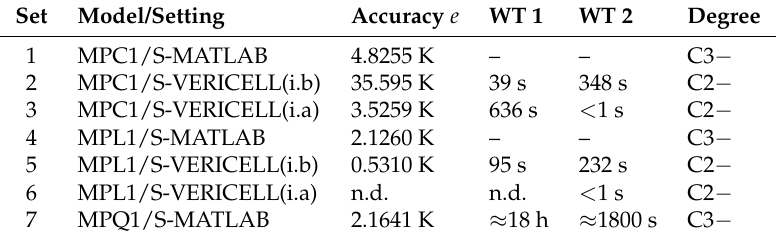
Figure 4. Simulated temperatures for different parameter sets (cf. Table 3) in comparison to measurements in case of MPC1 (left) and MPL1 (right). Since the curves are very similar for MPL1, we show only a plot close-up in the Figure. “Cf” means that the closed-form solution was used, otherwise VNODE-LP. A MATLAB solver was employed to identify the parameters from Sets 1 and 4. For parameters in Sets 2, 3 and 5, the solver IPOPT was used. The parameters for Set 6 are the same as for Set 5. Table 3. Results for MPC1/MPL1 under different conditions. Results for MPQ1 as a comparison. WT1 is the wall time for the optimisation, WT2 for the simulation. The parameter identification using the closed form solution and IPOPT have not been carried out yet for MPL1 due to reasons explained in Section 3.2, therefore “n.d” for Set 6 means “not done”. Times in MATLAB are given only once as a